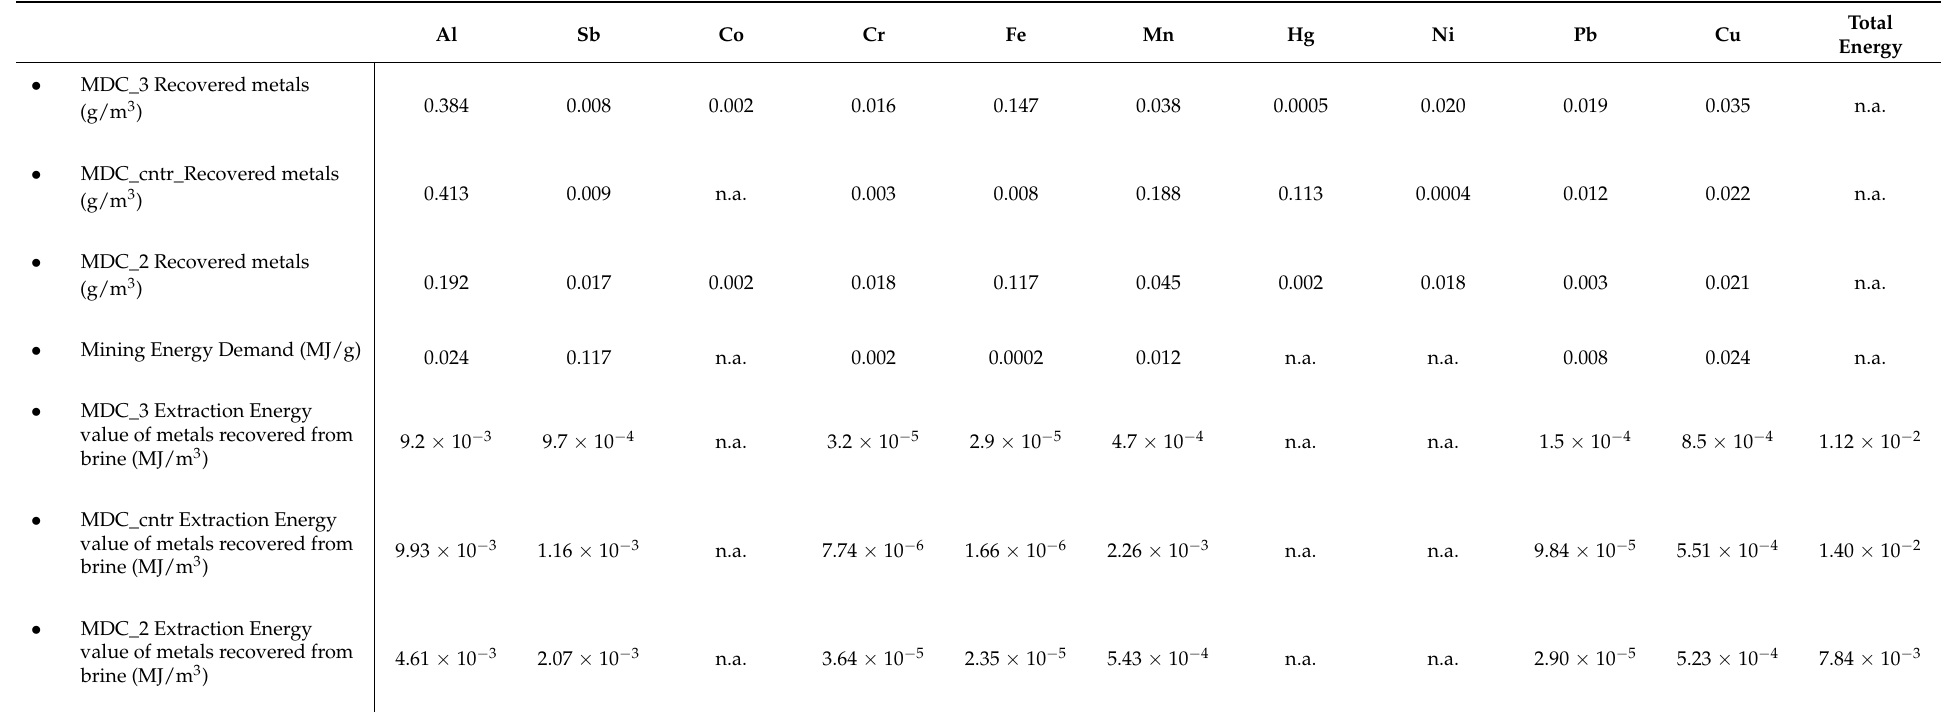
Table 4. Energy values of metals mining vs extraction from brine, based on Nuss et al., 2014